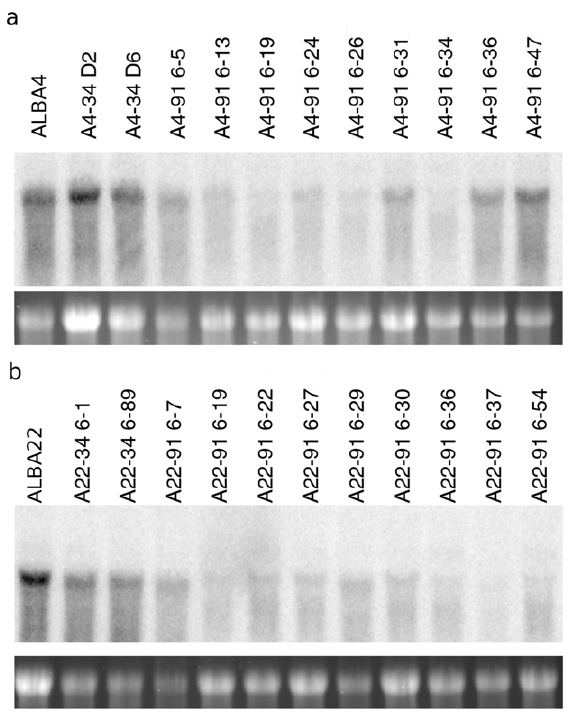
Figure 2. RNA blot-hybridization of lines transformed with CAD silencing construct pEC129. ( a ) Top panel shows autoradio- gram of total RNA from individuals derived from line ALBA4 and hybridized with a radiolabelled PviCAD2 probe derived from the 3 9 region of the coding sequence separate from the region used for silencing. Bottom panel is an image of the ethidium bromide stained gel for reference. Labels above the autoradiogram indicate individual identity. The first three individuals on the left are control untransformed (ALBA4) and vector transformed (A4 34-D2 and D6). ( b ) Same as in (a) but with total RNA from lines derived from ALBA22. First three individuals on the left are control untransformed (ALBA22) and vector transformed (A22-34 6-1 and 6–89).